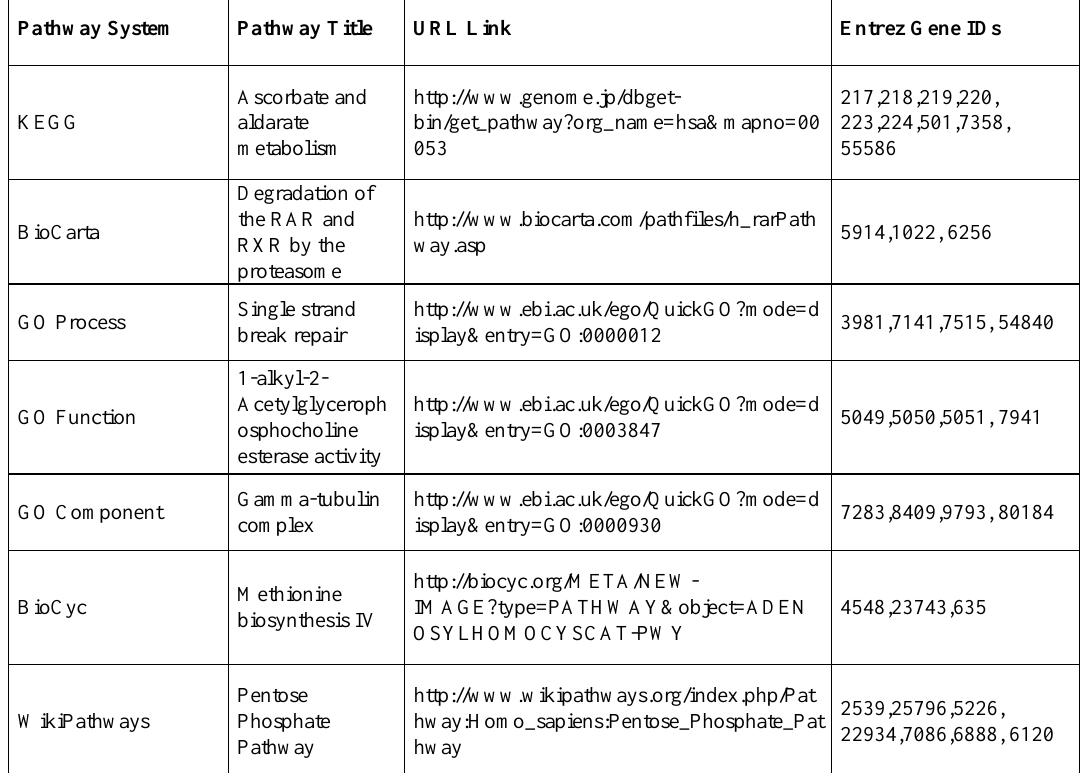
Table 7: Sample biological pathway information inherent within METU-SNP